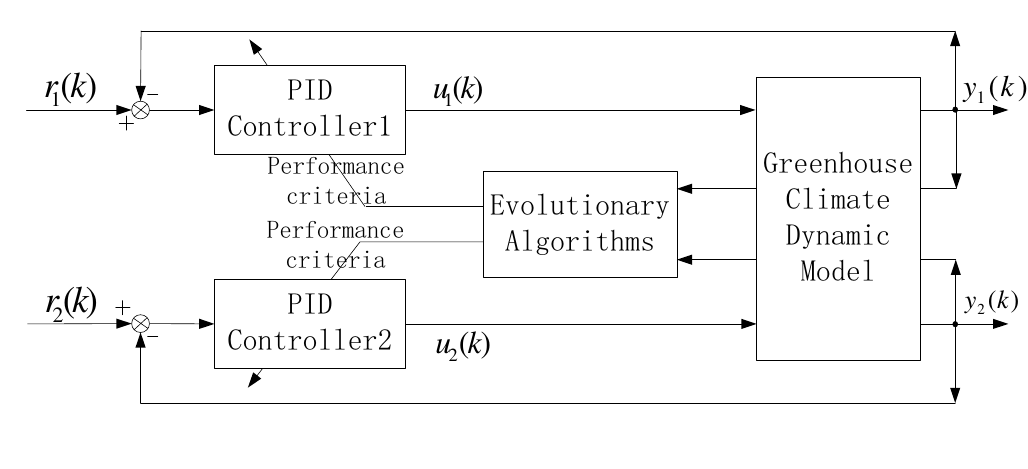
Figure 2. The diagram of a greenhouse climate control